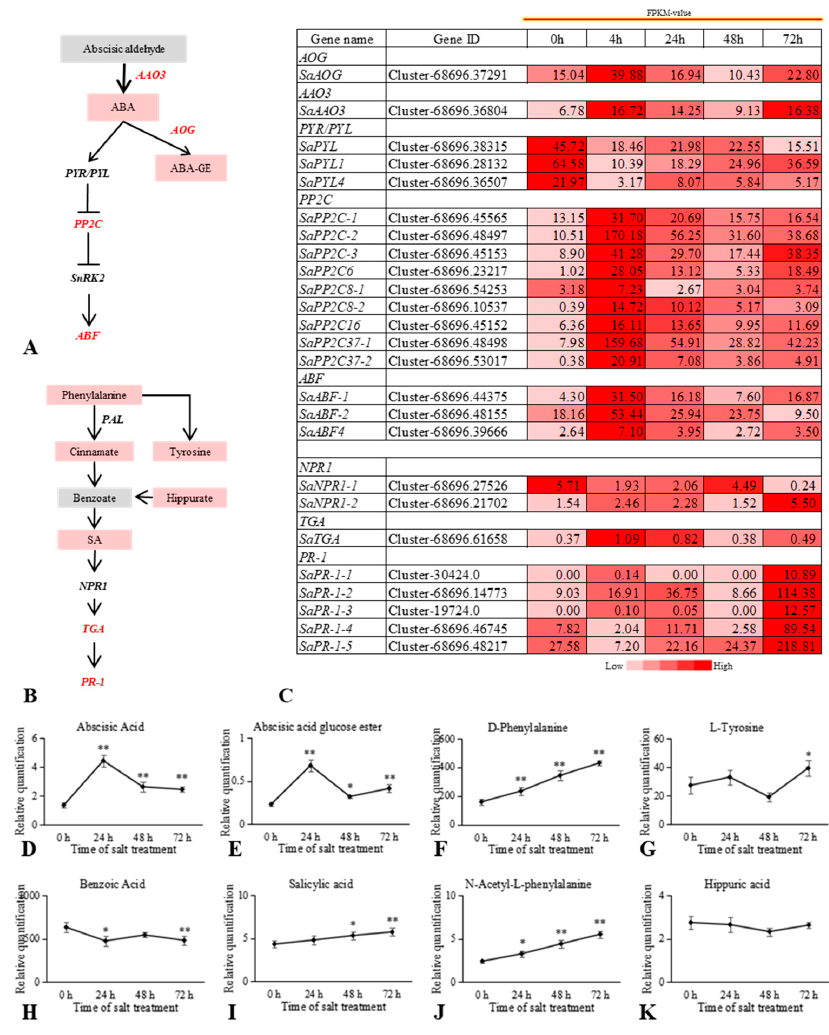
Figure 8. Overview of the relationship between differentially expressed genes (DEGs) and differential metabolites (DMs) in the ABA and SA signaling pathway of Sophora alopecuroides under salt stress. ( A ) Overview of ABA signaling pathway. ( B ) Overview of SA signaling pathway. ( C ) Heat map of ABA and SA signaling pathway-related gene expression. Values are average FPKM value of each sample in each group. ( D – K ) The trend in ABA and SA signaling pathway DM changes with salt stress. The horizontal axis represents the time of salt treatment, and the vertical axis represents the relative quantification of metabolites (peak area × 10 6 ). Expression levels of six independent samples of metabolites and the control were compared by t -test, where ** represents p < 0.01 and * represents p < 0.05. Expression scores are shown as fold-change. AAO3, abscisic-aldehyde oxidase; ABA, abscisic acid; ABA-GE, abscisic acid glucose ester; ABF, ABA responsive element binding factor; NPR1, regulatory protein NPR1; PAL, phenylalanine ammonia-lyase; PP2C, protein phosphatase 2C; PR-1, pathogenesis-related protein 1; PYL, abscisic acid receptor PYR/PYL family; SA, salicylate; SnRK2, Abrus precatorius serine/threonine-protein kinase SAPK2-like; TGA, transcription factor TGA.